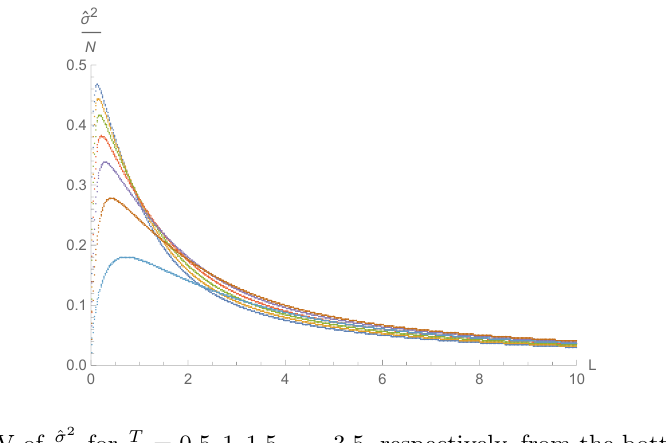
Figure 4 . VEV of ^ (cid:27) 2